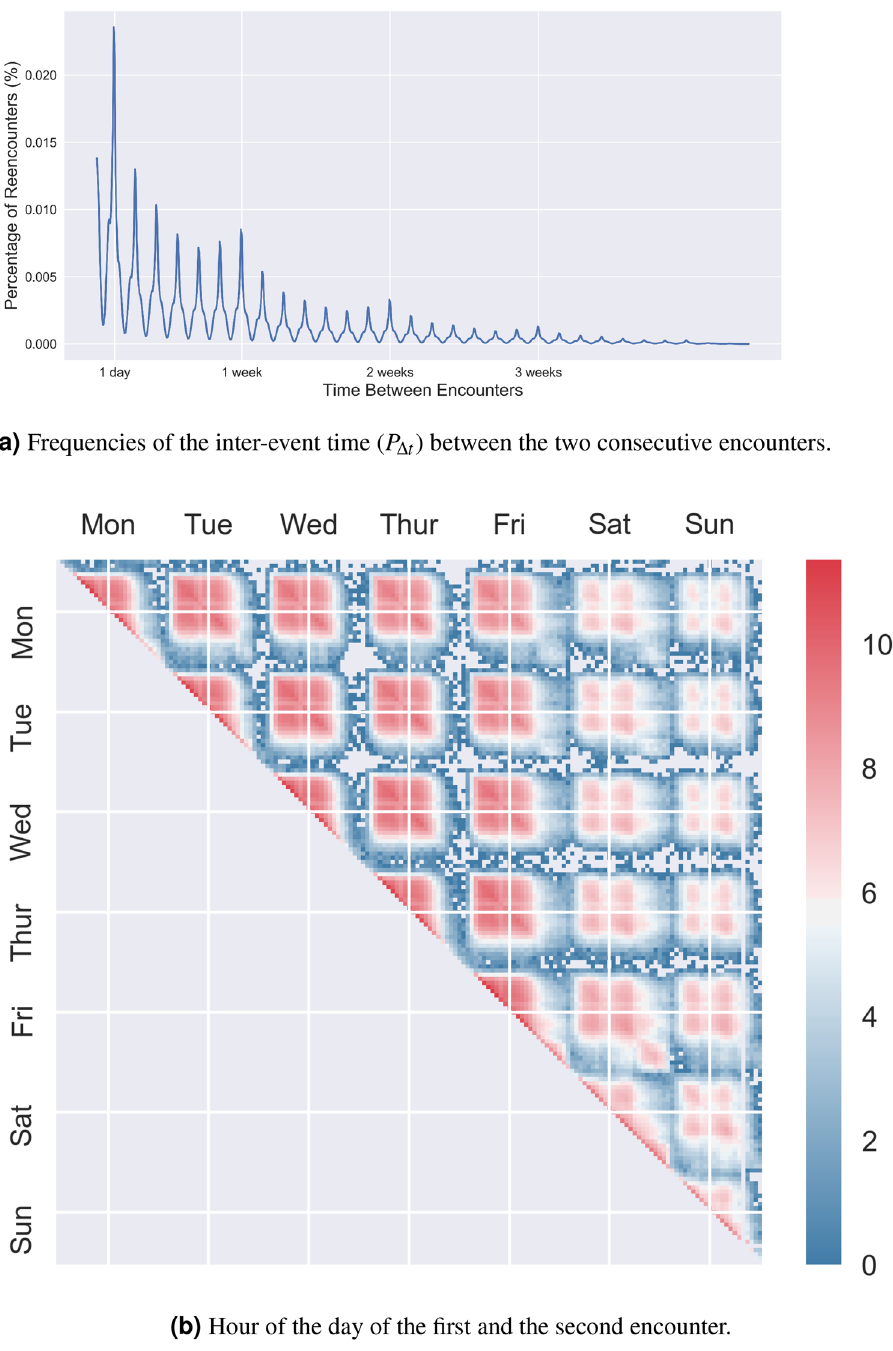
Figure 2. Temporal regularity. ( a ) Frequencies of the inter-event time ( P (cid:31) t ) between the two consecutive encounters. The x-axis corresponds to the number of hours between the two repeated encounters of a pair of familiar strangers. The y-axis is the number of encounter pairs. ( b ) Hour of the day of the first and the second encounter. The y-axis and the x-axis correspond to the time of the day of the first and the second encounter. The color scale represents the frequencies of the encounters with the corresponding count ascending from blue to